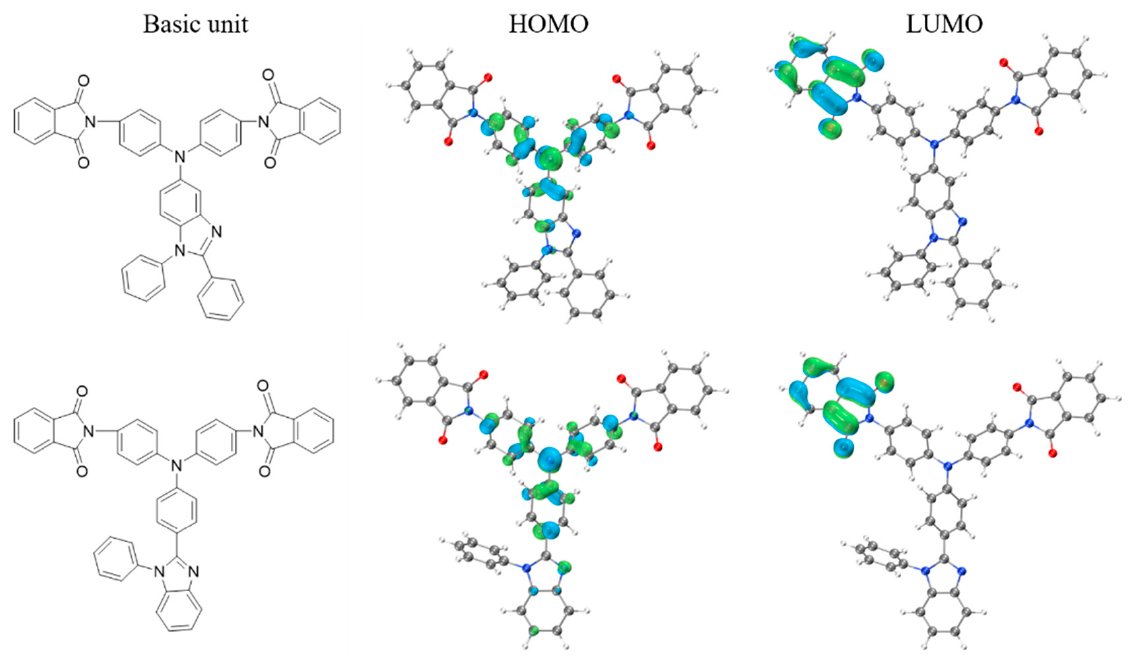
Figure 7. Calculated molecular orbitals of the model compounds (TD-DFT method at the B3LYP/6- 31G (d, p)).